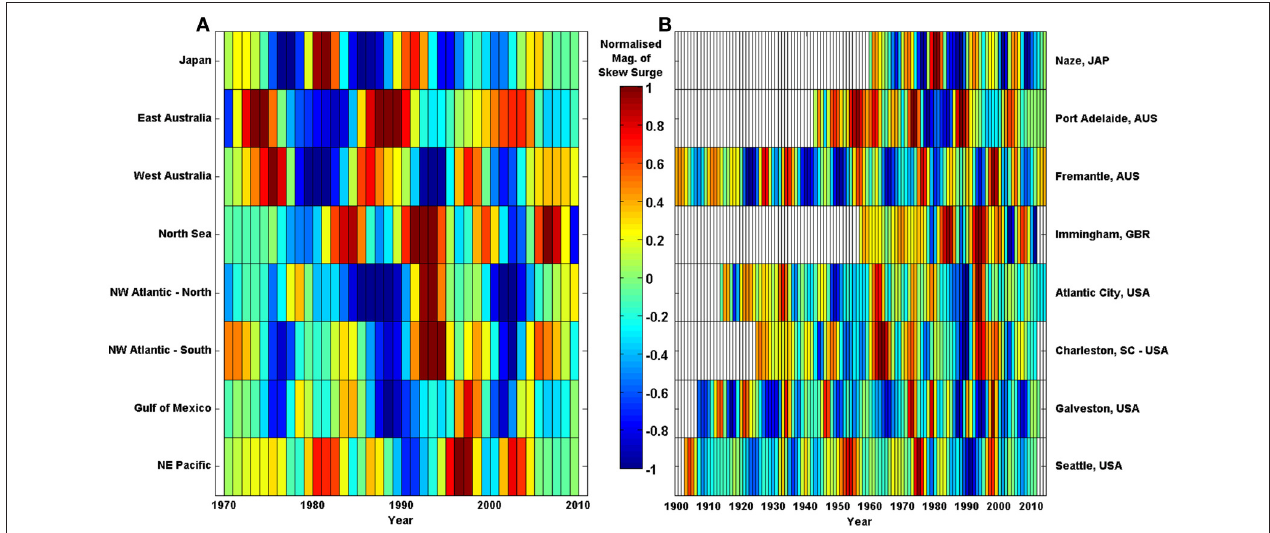
FIGURE 10 | Temporal variability of 8 selected regions as shown by the de-trended normalized and then filtered magnitude of skew surge for: (A) regional indices; (B) selected long site from each region, which has a strong correlation with the regional index.